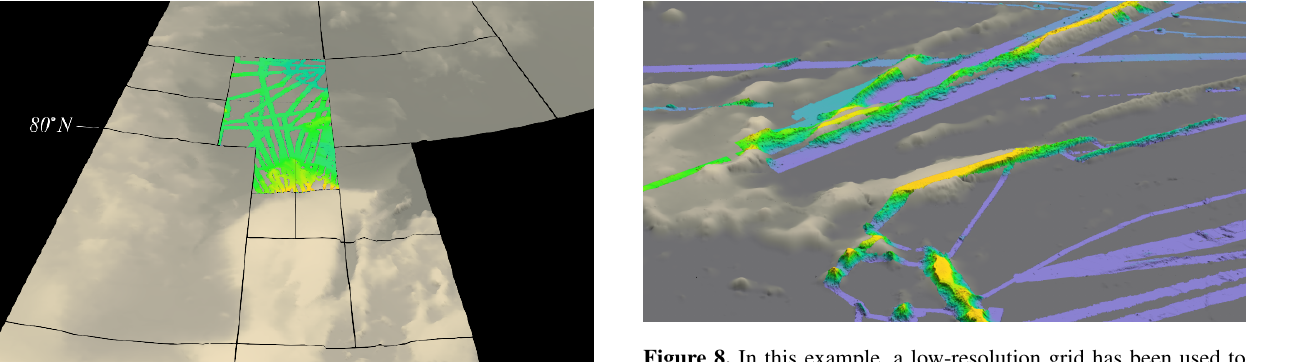
Figure 8. In this example, a low-resolution grid has been used to fill in around a high-resolution multibeam data. Two colormaps are used with highly saturated colors being used to highlight multibeam data.